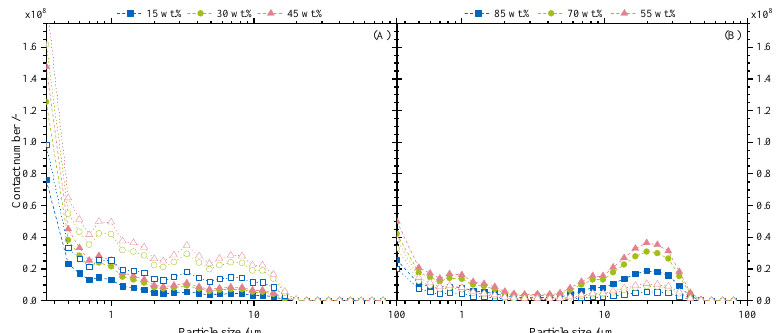
Figure 5. Contact number distribution of protein ( A ) and starch ( B ) particles. Closed symbols indicate the interaction with different materials, whereas open symbols show interaction with the same material. Protein shows a higher contact number for small particles. A higher initial protein content leads to higher contact numbers.